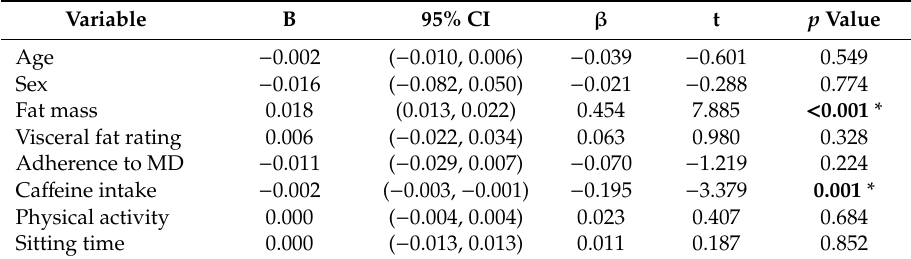
Table 11. Multiple linear regression for C-reactive protein (CRP).